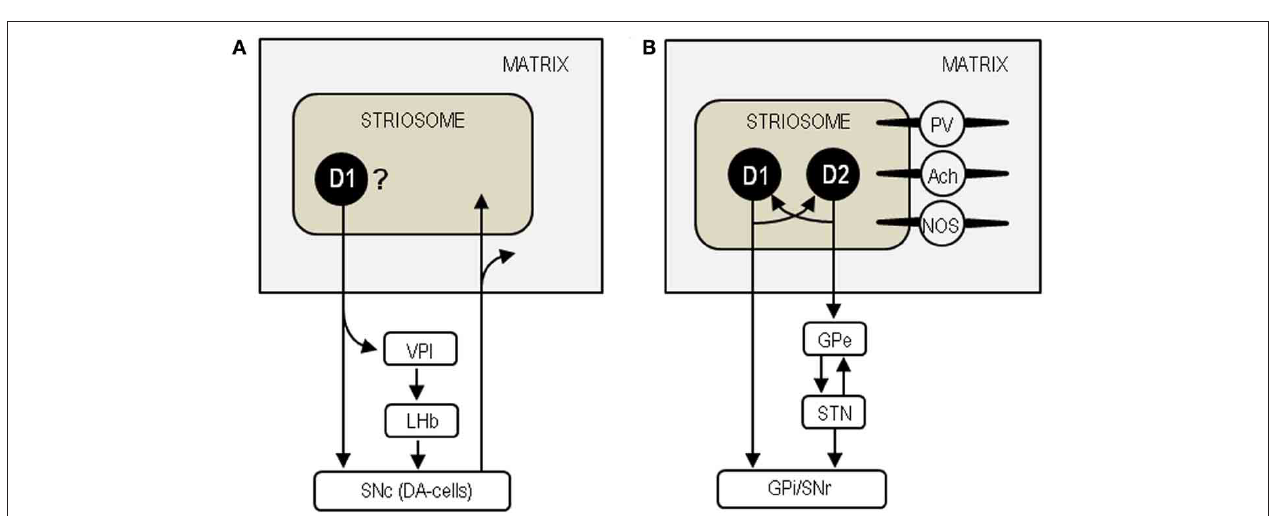
of striatal labeling for MOR, DOR, and KOR under the conditions of dopamine depletion. Innormal controls, aheightened labeling for MORsor DORsisfound in the striosomes (S). Striatal dopamine depletion causes marked reduction of MOR- and DOR-labeling in the striosomes, but not in the matrix compartment (M). Neuronal cell bodies labeled for DOR or KOR are indicated by small dots.